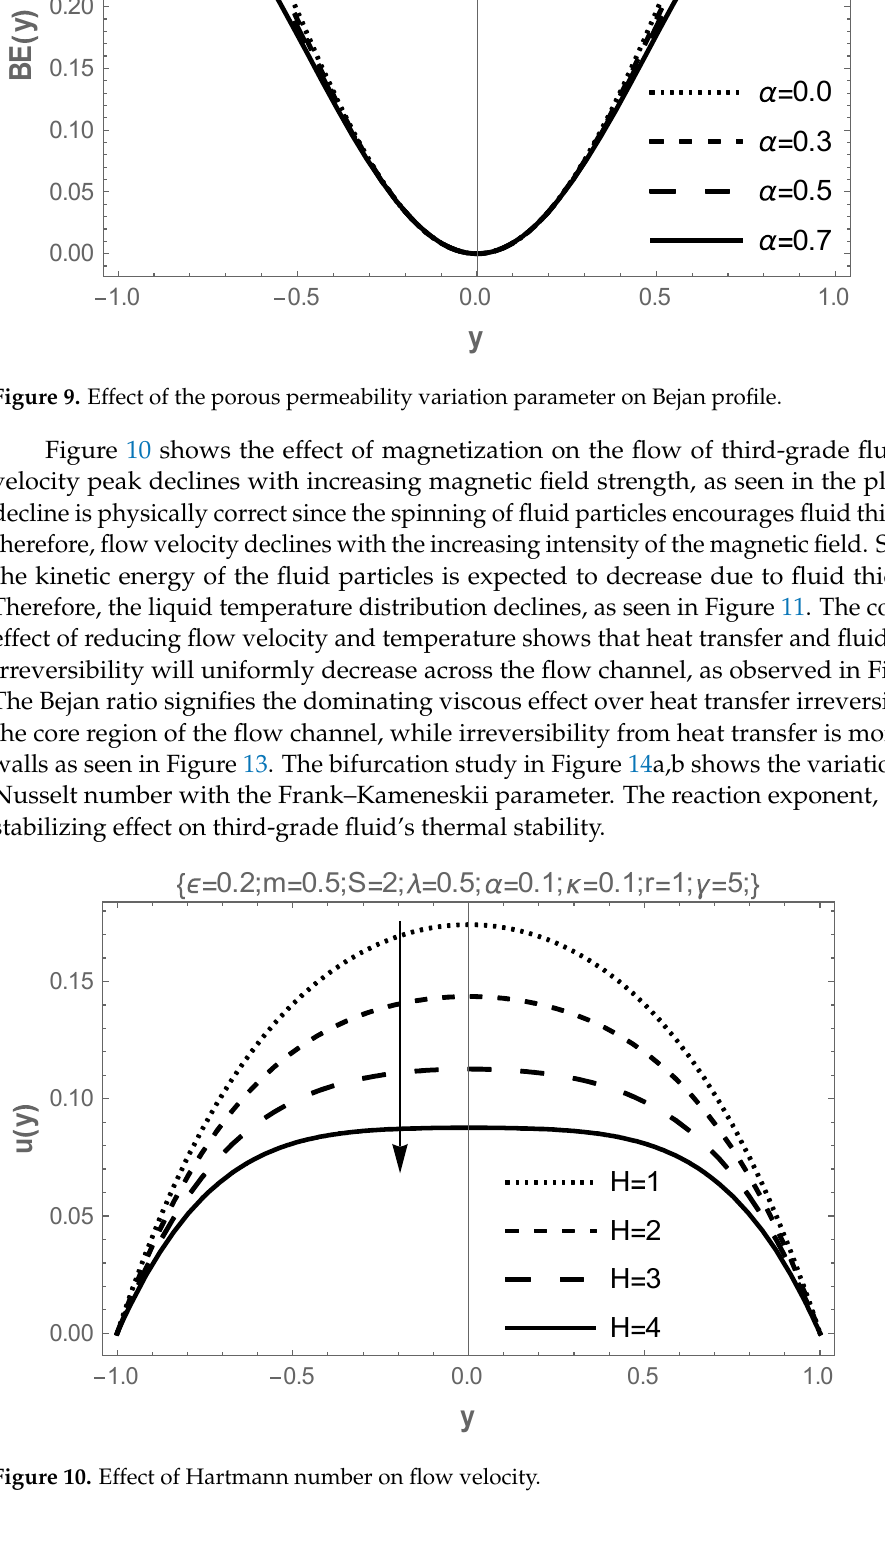
Figure 10. Effect of Hartmann number on flow velocity.